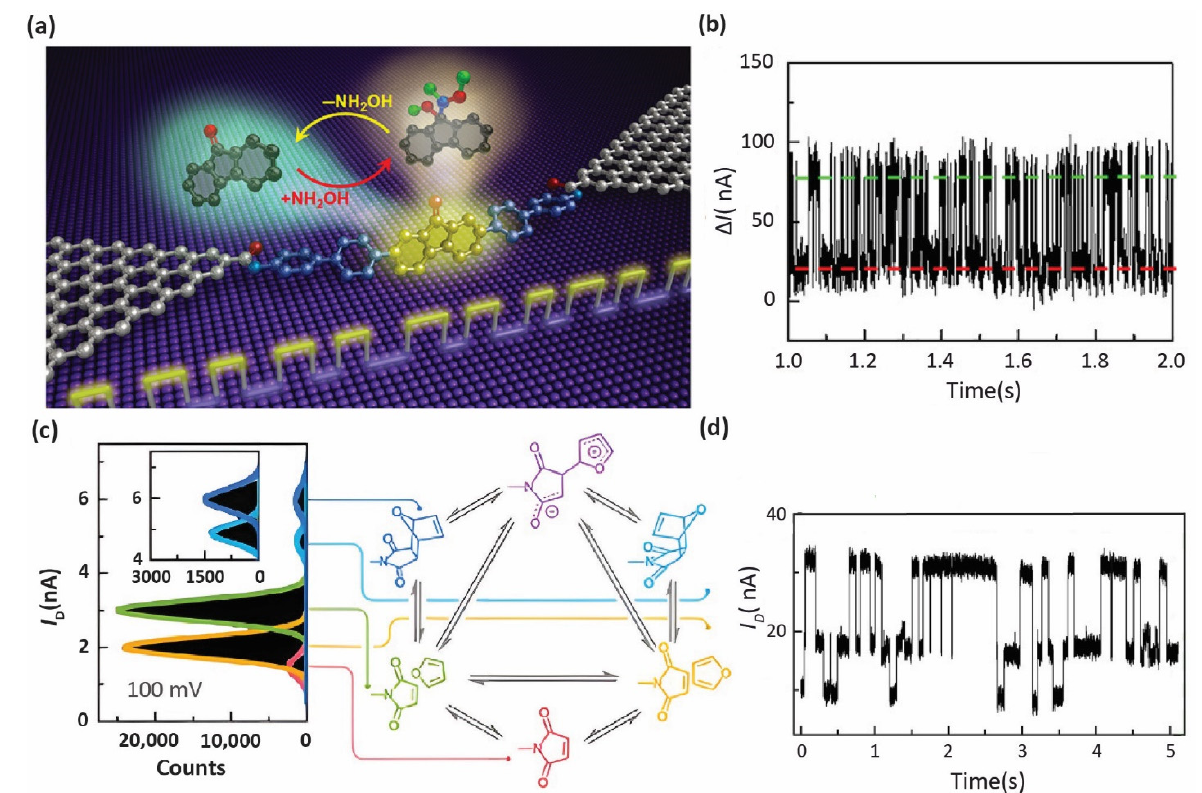
Figure 3. Reaction dynamics in SMJs. ( a ) Schematic representation of a reversible nucleophilic addition reaction of hydroxylamine to carbonyl. ( b ) Bimodal real-time current signals of a nucleophilic addition reaction. Figures were reproduced with permission from reference [48]. Copyright 2018, Science Advances. ( c ) Multiple conductance states corresponding to several intermediate states in a Diels–Alder reaction mechanism at 100 mV. ( d ) Multimodal real-time current signal. Figures were reproduced with permission from reference [50]. Copyright 2021, Science Advances.